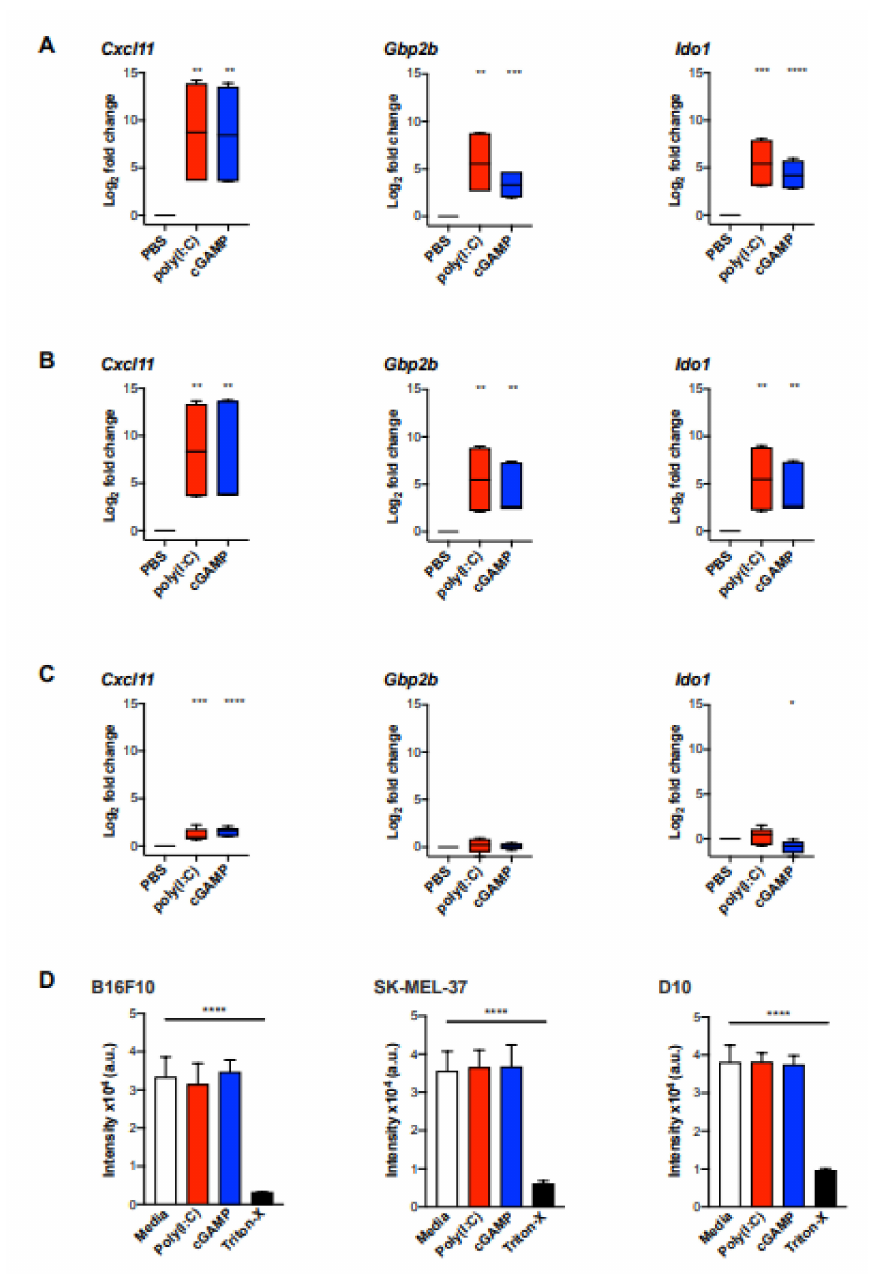
Figure 4. The MA signature expression was significantly induced in bone marrow-derived macrophages (BMDM) but not in melanoma cells upon stimulation with poly(I:C) or cGAMP in vitro. BMDM from three biological replicates were stimulated with poly(I:C) (10 µ g / mL) or cGAMP (10 µ g / mL) for 6 h ( A ) and 24 h ( B ), following gene expression analysis for Cxcl11 , Gbp1 , and Ido1 by qPCR ( n = 6). ( C ) B16F10 melanoma cells were cultured with poly(I:C) (10 µ g / mL) or cGAMP (10 µ g / mL) for 24 h following gene expression analysis by qPCR ( n = 6). Data are represented as mean ± standard error of log 2 transformed values. Data were normalized to the housekeeping gene Rplp0 [21]. ( D ) Cell viability of B16F10 and human melanoma cell lines SK-Mel-37 and D10 upon stimulation with poly(I:C) and cGAMP was assessed by AlamarBlue assay. Cell lines were incubated with poly(I:C) (10 µ g / mL), cGAMP (10 µ g / mL) for 24 h. After 6 h of incubation with AlamarBlue (10% v / v ), fluorescence intensity was measured. Statistical analysis was performed using an unpaired, two-tailed Students t -tests and the p values are indicated as follows: p > 0.05 (ns), p ≤ 0.05 (*), p ≤ 0.01 (**), p ≤ 0.001 (***), p ≤ 0.0001